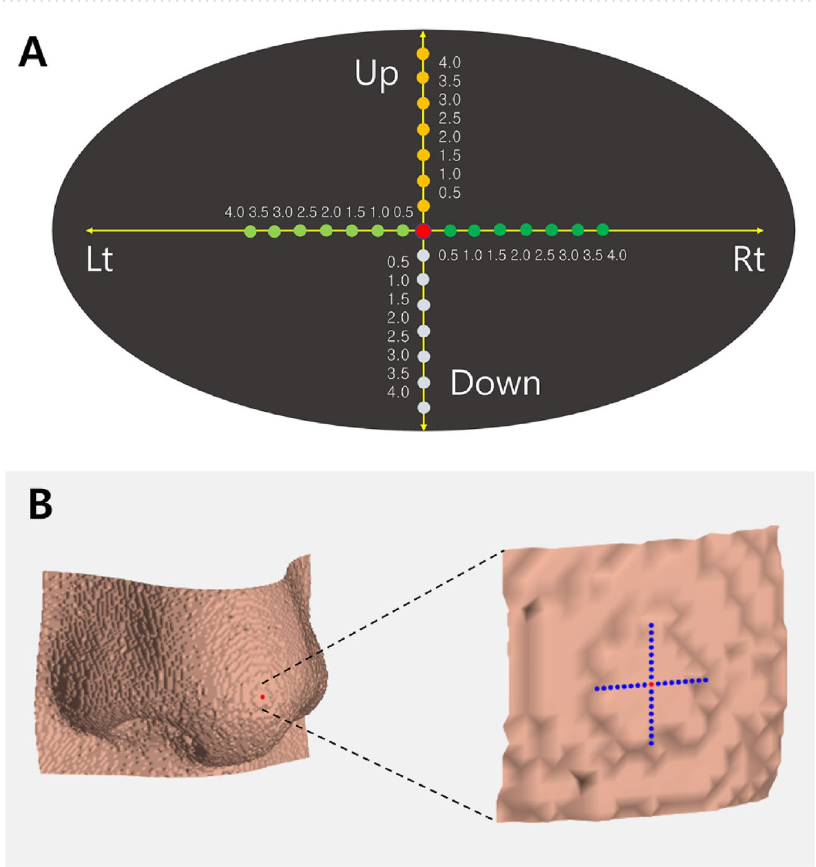
Figure 5. Consistency examination of CC point. ( A ) The distance between the original coordinate and second coordinate that was moved 0.5 pixels in each direction point (yellow, light green, green, and white dots) was compared; red dot, original coordinate; yellow arrow, movement direction; Up, upward; Down, downward; Rt, rightward; Lt, leftward. ( B ) Example for pronasale; the red dot was an original CC point; blue dots are coordinates that were moved by 0.5, 1.0, 1.5, 2.0, 2.5, 3.0, 3.5, and 4 pixels in the up, down, left, and right